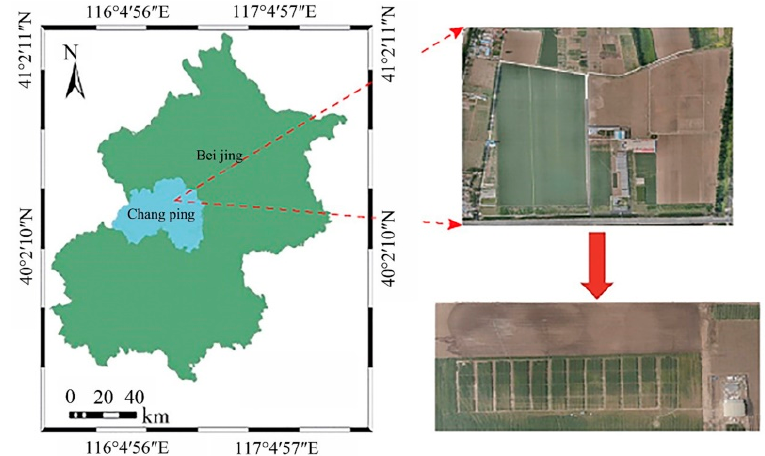
Figure 1. Geographical location of study area.